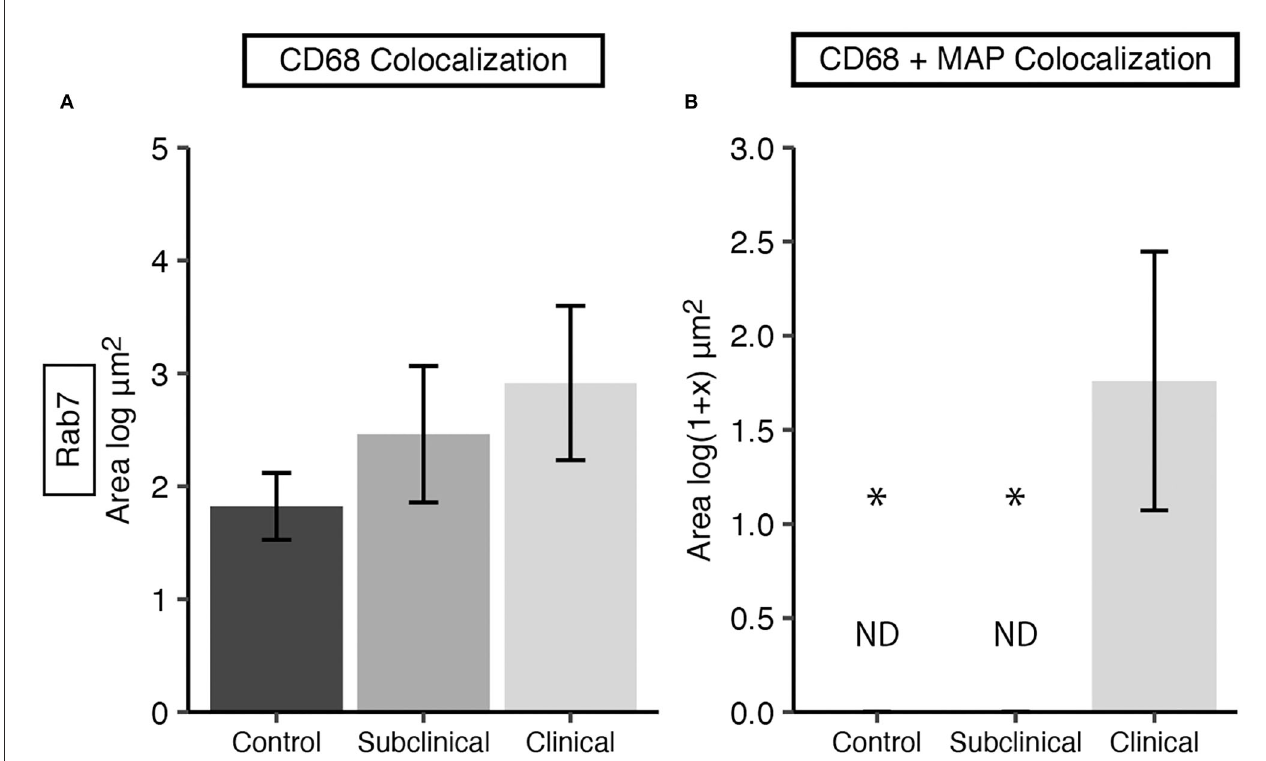
FIGURE5 Late endosomal marker Rab7 expression in frozen tissue sections from bovine mid-ileum. Cows were grouped according to stage of paratuberculosis infection (clinical n = 9, subclinical n = 9, JD- control n = 8). (A) Rab7 expressed within CD68 + macrophages presented as the mean fluorescence area